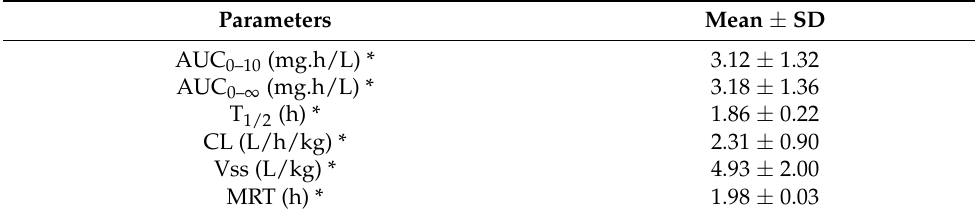
Figure 4. Mean ± SD plasma concentration-time profile of OJT007 after a single 5 mg/Kg intravenous dose to male Sprague-Dawley rats. Table 6. Pharmacokinetic parameters (Mean ± SD) after the intravenous administration of 5 mg/Kg OJT007 to male Sprague-Dawley rats ( n =